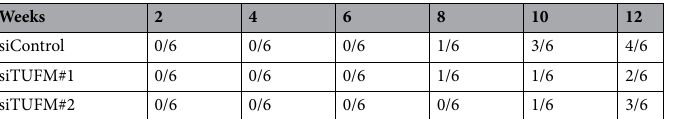
Table 2. Tumorigenicity assay. Control or TUFM knock down HuCCT1 cells were injected into NOG mice subcutaneously (10 2 cells per site. Six sites total). The number of palpable tumors were